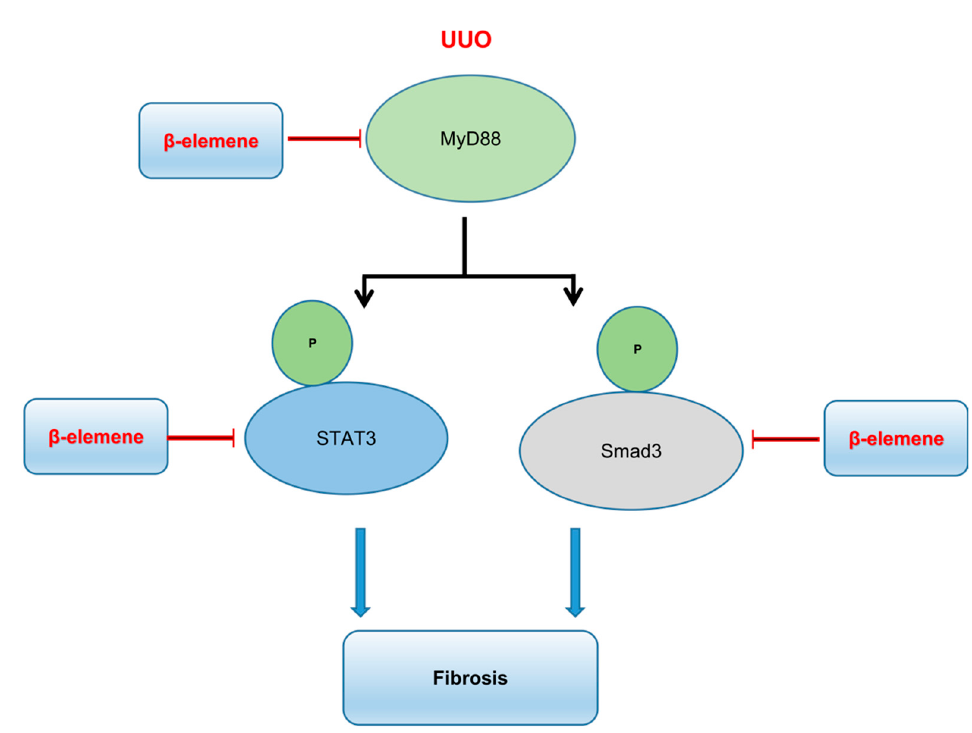
Figure 9. Schematic diagram of the mechanism of action of β -elemene on the therapeutic effect of fibrosis in UUO mice.